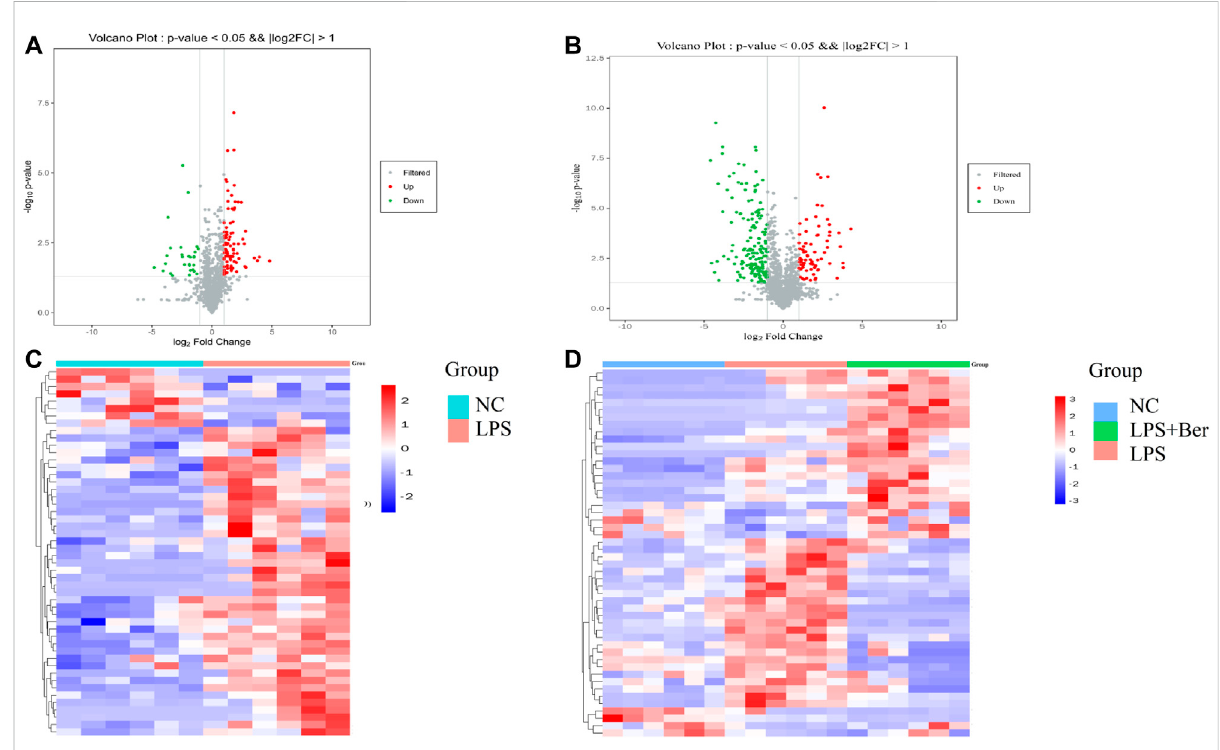
FIGURE 3 (A) Volcano plot of LPS versus NC. Red circles have an FDR value < 0.05, indicating a signi fi cant increase in LPS. Green circles have an FDR value < 0.05, indicating a signi fi cant decrease in LPS. (B) Volcano plot of LPS versus LPS + Ber. Red circles have an FDR value < 0.05, indicating a signi fi cant increase in LPS. Blue circles have an FDR value < 0.05, indicating a signi fi cant decrease in LPS. (C) A heatmap shows that the top 20 metabolites can separate LPS and NC. (D) A heatmap shows that the top 20 metabolites can separate LPS, NC, and LPS + Ber